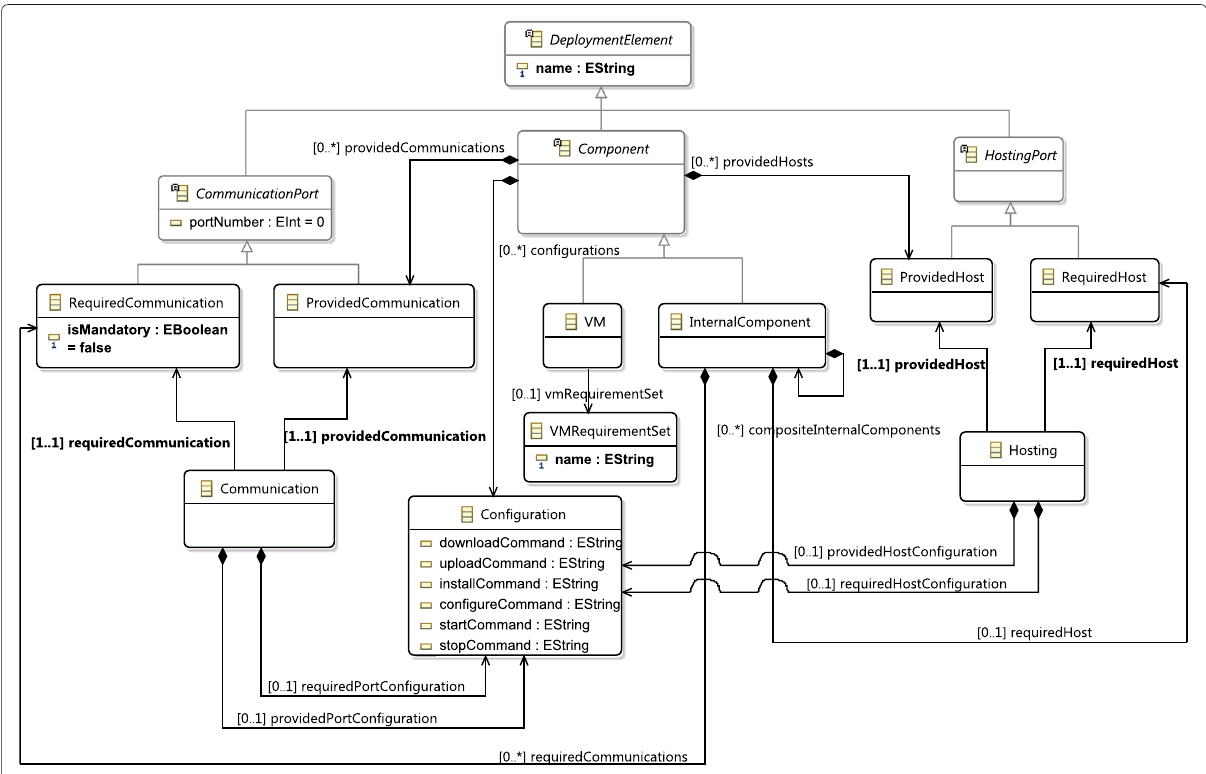
Fig. 4 The type part of the deployment metamodel